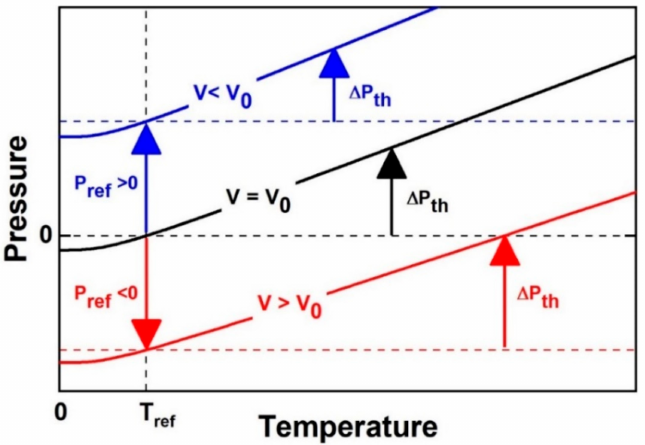
Figure 1. The concepts and definitions of the various pressures and variables used in thermal pressure EoS, illustrated for three di ff erent volumes. The solid lines are the isochors for three di ff erent volumes. At pressures above the isochor of V 0 the volume V is smaller than V 0 and this is obtained with a positive pressure P ref (blue in Figure 1). On the other hand, for P , T conditions below the isochor of V 0 the V is greater than V 0 , and the material must be expanded at T 0 to obtain the required V . This means that P ref < 0 (red in Figure 1). The isochor passing through the reference conditions therefore divides P–T space into two regions: at P above this reference isochor the P ref is positive, but at pressures below the reference isochor the P ref is